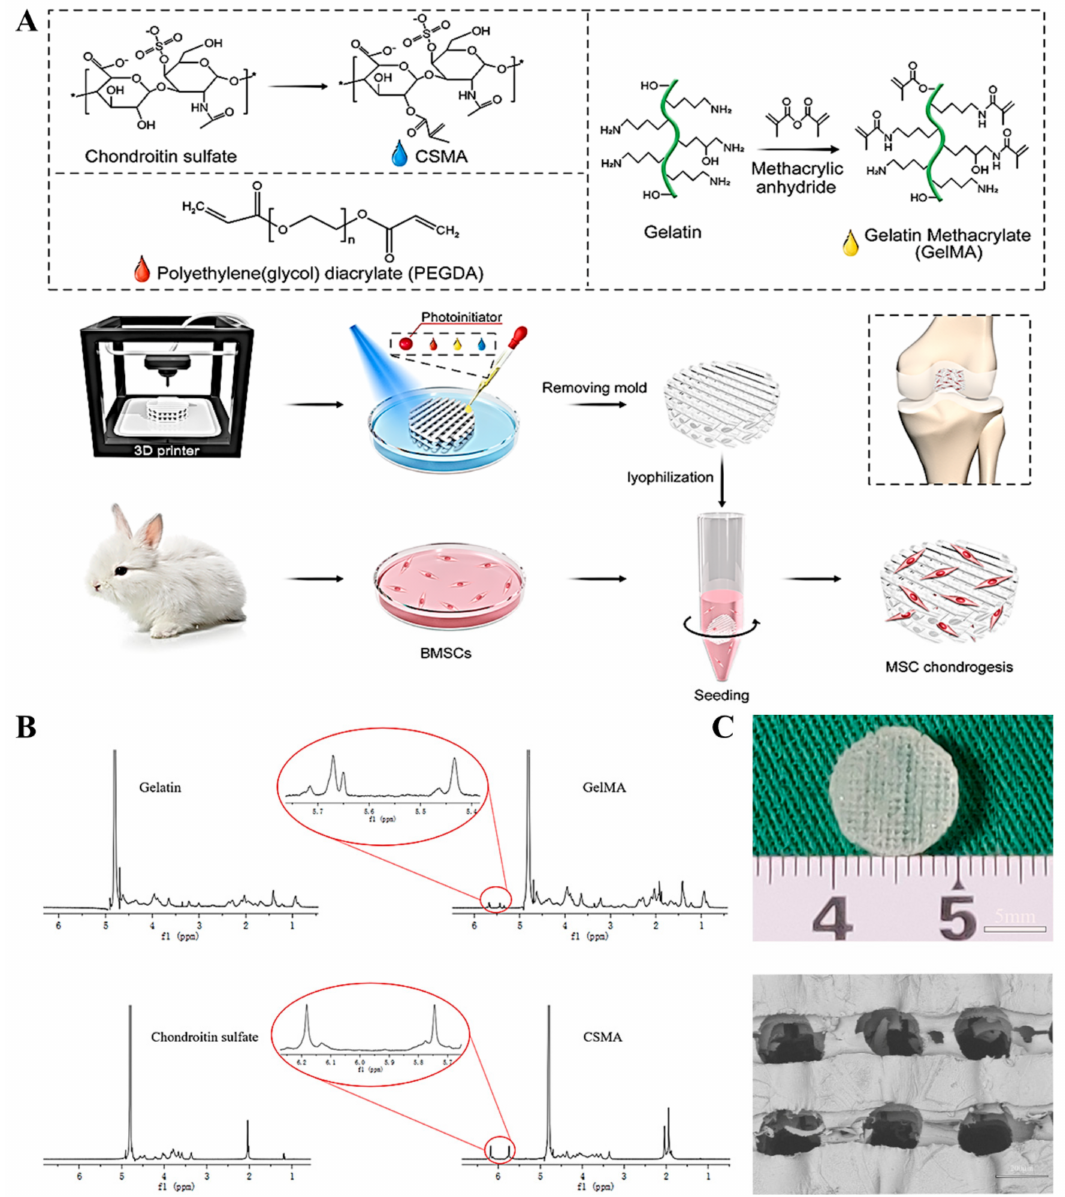
Figure 1. Fabrication of 3D-printed hydrogel scaffolds. ( A ) Synthetic route of CSMA and GelMA and the schematic illustration of 3D printing of scaffolds as well as the isolation and seeding of cells on the printed scaffolds. ( B ) 1 H-NMR spectra of GelMA and CSMA. ( C ) Macroscopic and SEM images of the 3D spatial structure of